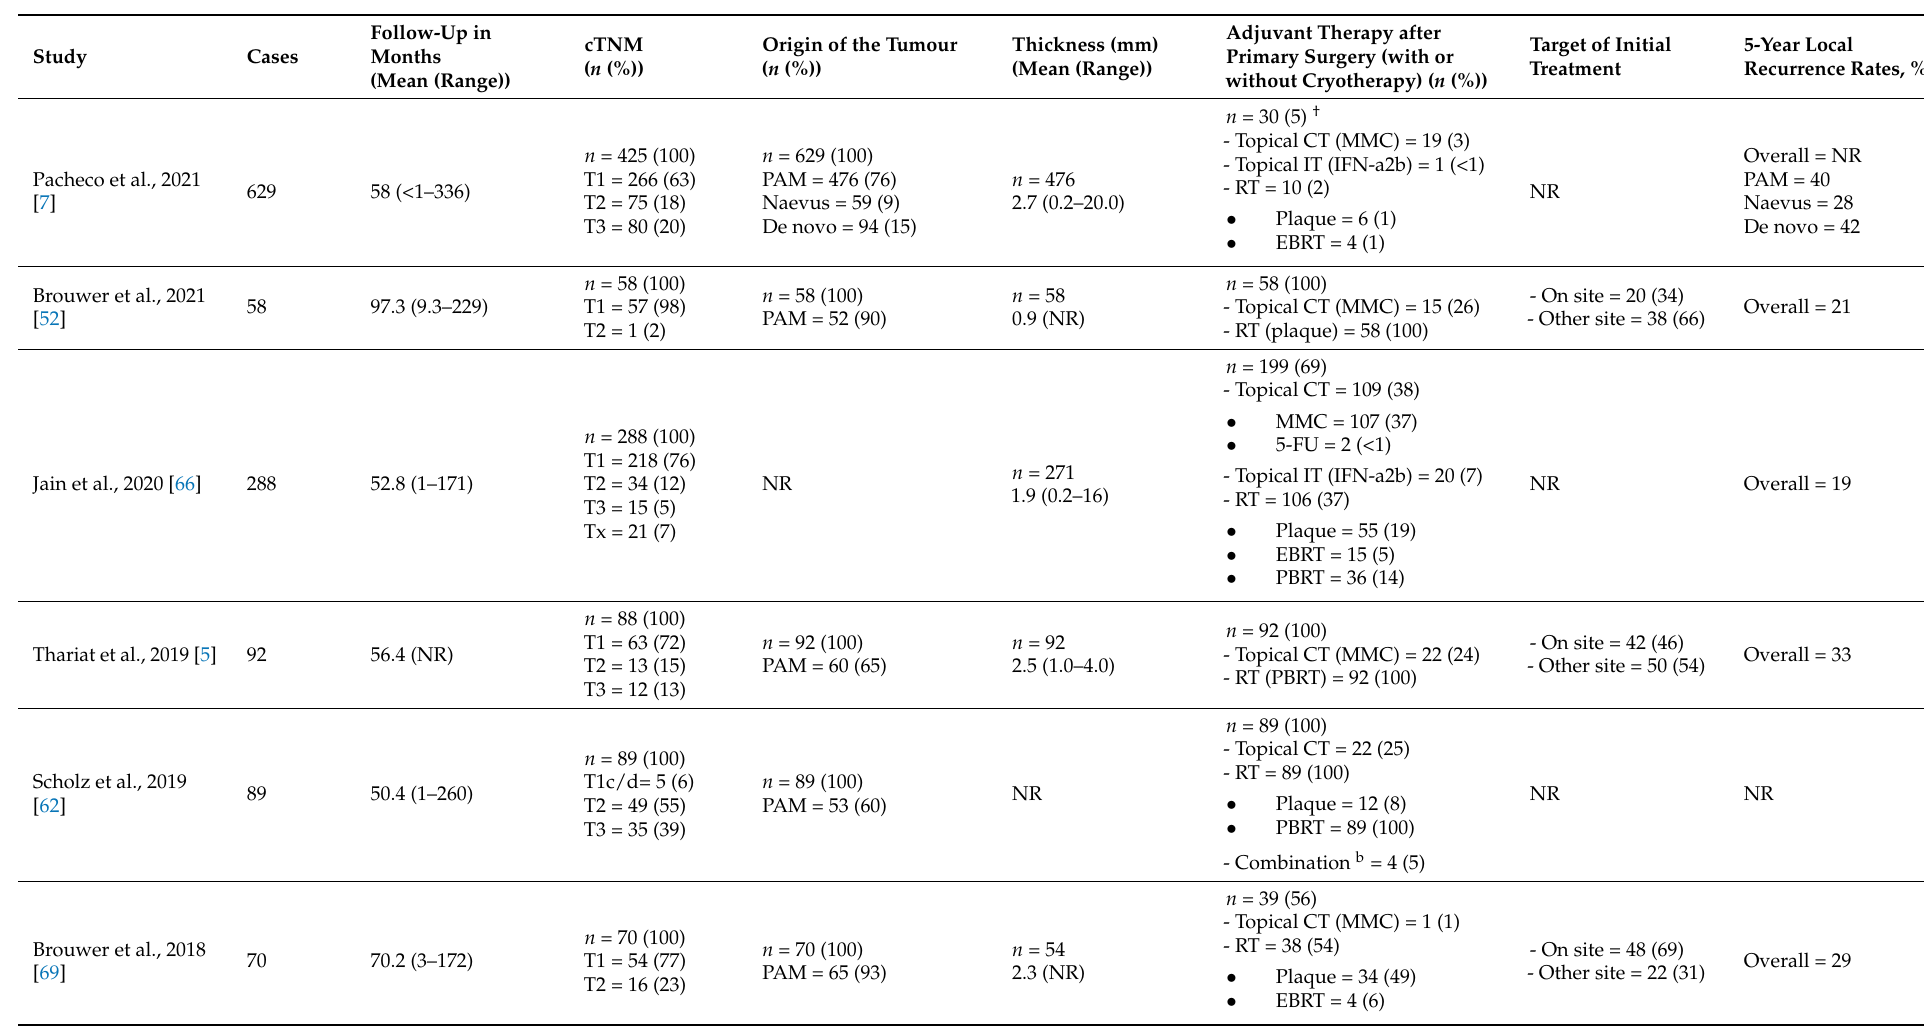
Table 1. Case series of more than 10 patients describing the use of radiotherapy for treating conjunctival